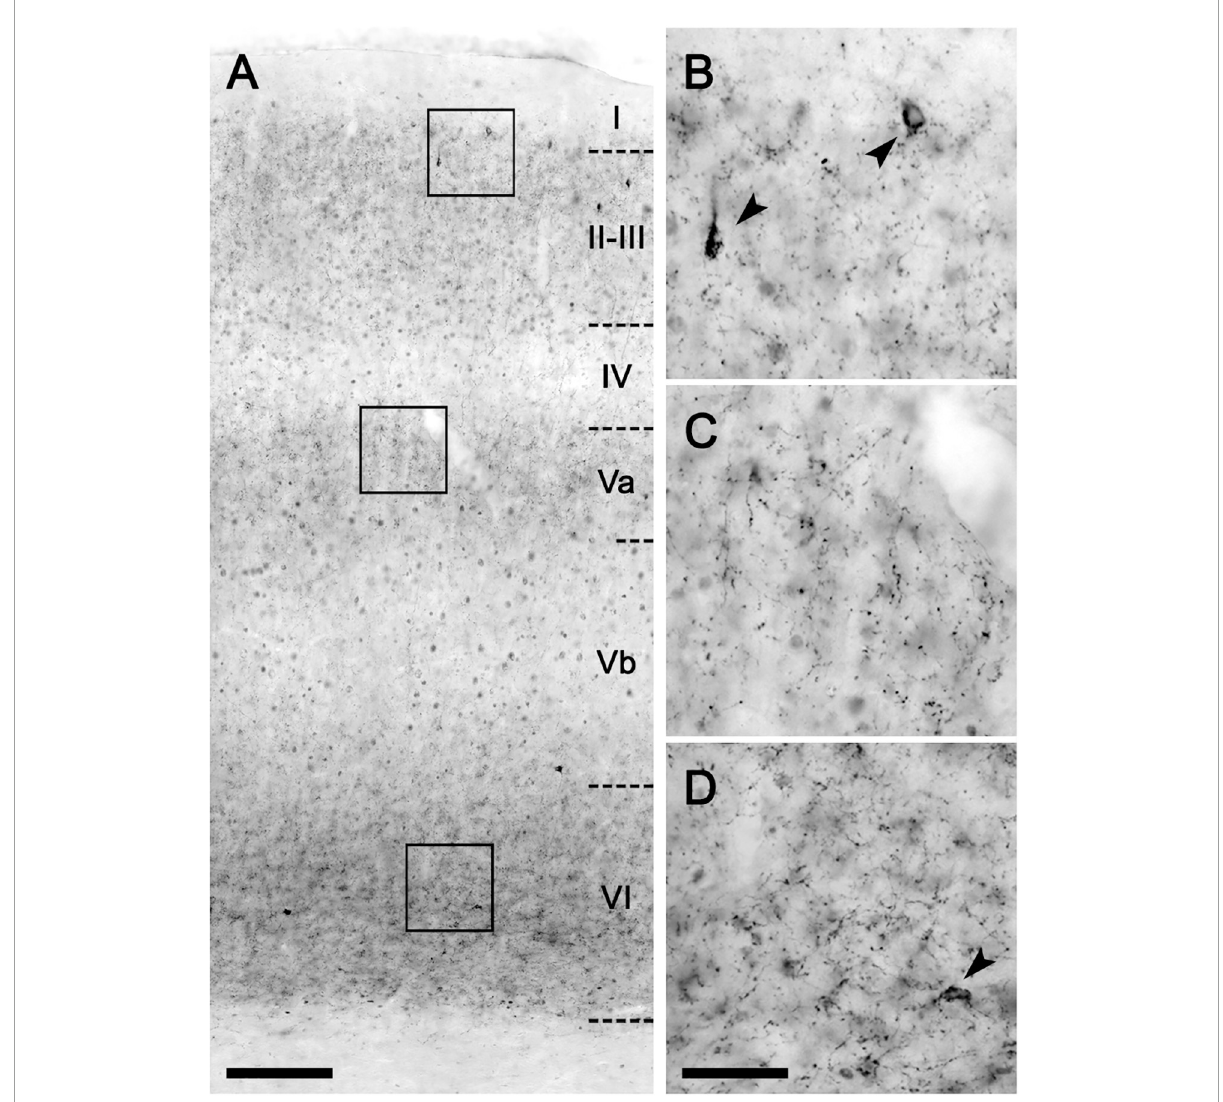
FIGURE2 CB 1 -immunohistochemical staining pattern in the neocortex of the lean Zucker rat. (A) Low magnification micrograph of the primary motor neocortical area showing the layer distribution of CB 1 -immunostaining. (B–D) Higher magnification images of areas framed in A to illustrate the immunostaining pattern in layers II (B) , Va (C), and VI (D) . Arrowheads indicate CB 1 -immunopositive interneurons. Scale bars = 100 µ m in (A) ; 25 µ m in (D) (applies to B–D